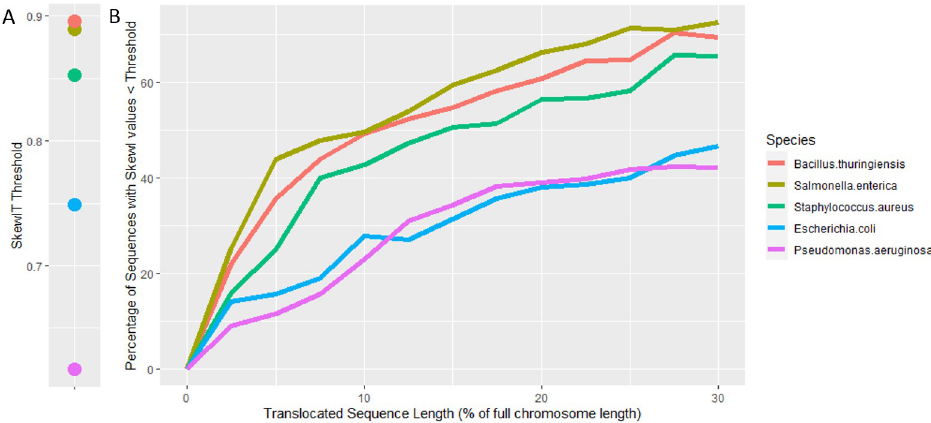
Fig 6. SkewIT sensitivity to misassemblies. In order to evaluate the sensitivity of the SkewIT method for detecting misassemblies, we first randomly selected 10 genomes from these species: Bacillus thuringiensis , Salmonella enterica , Staphylococcus aureus , Escherichia coli , and Pseudomonas aeruginosa . A) displays the SkewI threshold for each species. For each genome, we simulated 100 misassembled genomes by moving a random subsequence of length k % of the full genome length to another random location. This was repeated for 12 values of k ranging from 0 to 30, with 100 random misassemblies for each value of k . B) shows the average percentage of the misassembled genomes that had SkewI values below the